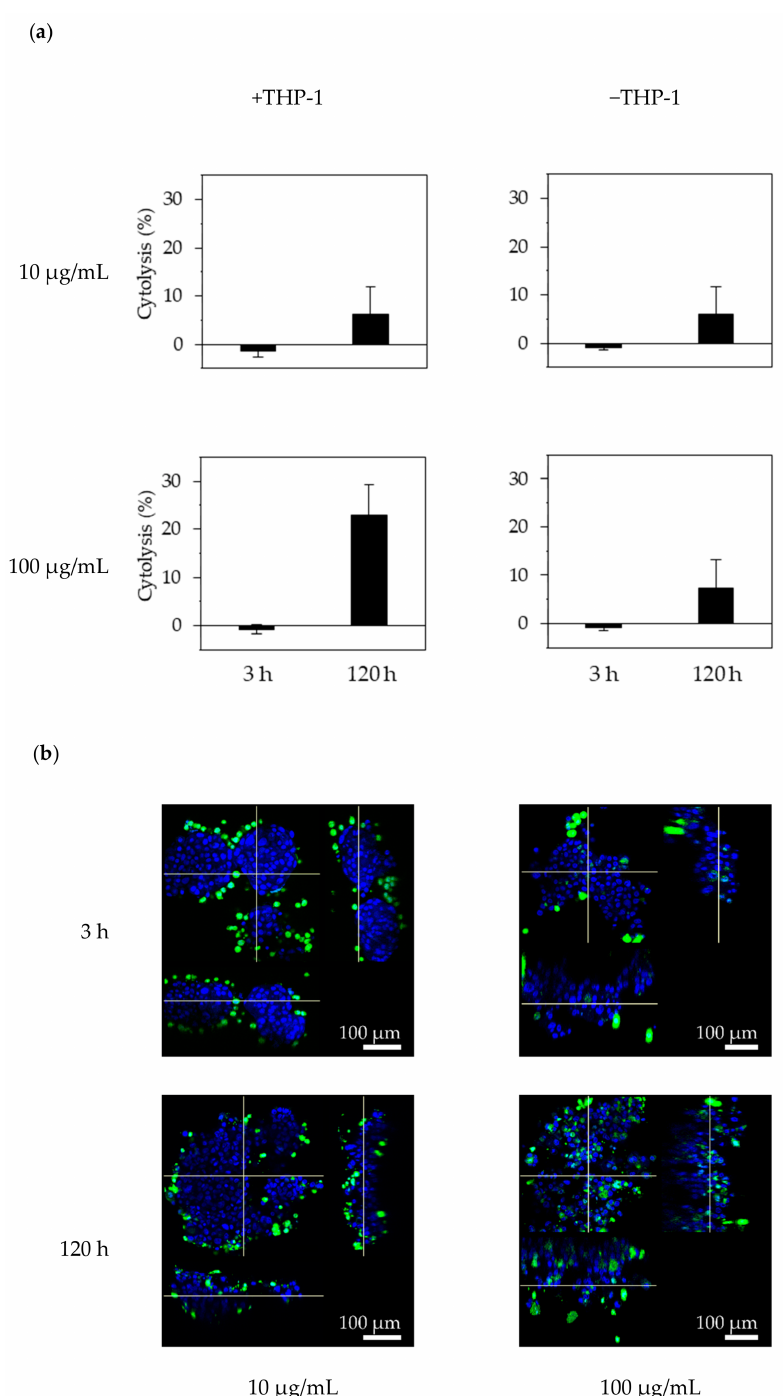
Figure 5. Antibody-dependent cellular cytotoxicity (ADCC) activity against RLUN21 cells with trastuzumab. ( a ) Cytolysis against RLUN21 by trastuzumab and THP-1 e ff ector cells was determined by performing lactate Dehydrogenase (LDH) assays. Cytolysis (%) was calculated as 100 × (LDH release in test well –LDH release from RLUN21 cells only –LDH release from THP-1 cells only) / (maximum LDH release from RLUN21 cells lysed using Triton X-100 –LDH release from RLUN21 cells only). Cytolysis was measured at 3 and 120 h after THP-1 addition. The error bars indicate the standard deviation from six replicate samples. ( b ) Interaction of THP-1 e ff ector cells with RLUN21 cell during ADCC. Magnification: × 30. Scale bar: 100 µ m. THP-1 cells stained using the Cell Explore Fixable Live Cell Tracking Kit are shown in green. DNA stained with DAPI is shown in